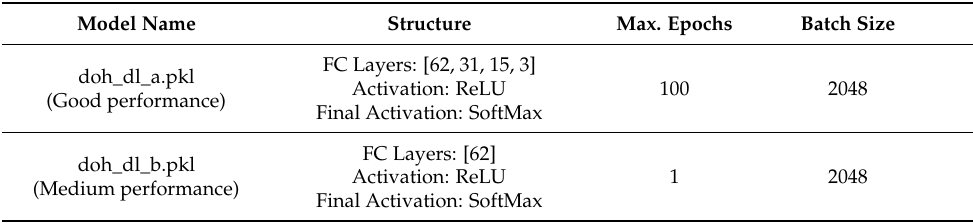
Table 6. Hyperparameters for each DoH Deep Learning model generated.